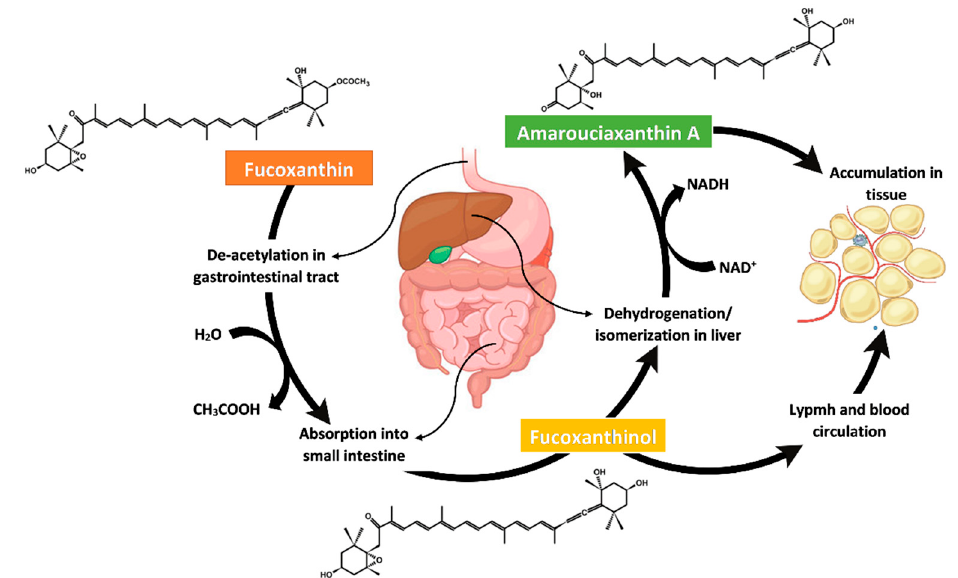
Figure 4. Metabolism of fucoxanthin. Given the ratio of fucoxanthin adsorption to its dose in metabolite analysis, fucoxan- thin metabolites of fucoxanthinol and amarouciaxanthin A have better levels of absorption than astaxanthin in mice [87]. Meanwhile, fucoxanthin was observed to be absorbed more efficiently than lutein esters in the mouse intestine, although both compounds have a simi- lar mechanism of absorption [87,90–92]. Fucoxanthin absorbed in the intestinal mucosal epithelial cell of the small intestine will enter the lymph circulation system before being reduced to amorouciaxanthin A in the liver. According to Matsumoto, et al. [90], although fucoxanthin was not found in the lymph duct and vein, its metabolite of fucoxanthinol was identified in the lymph fluid, indicating its conversion to fucoxanthinol via lymphatic absorption occurred in the intestine. It is also probable that several constituents such as dietary fibre present in the seaweed matrix inhibit fucoxanthin intestinal absorption